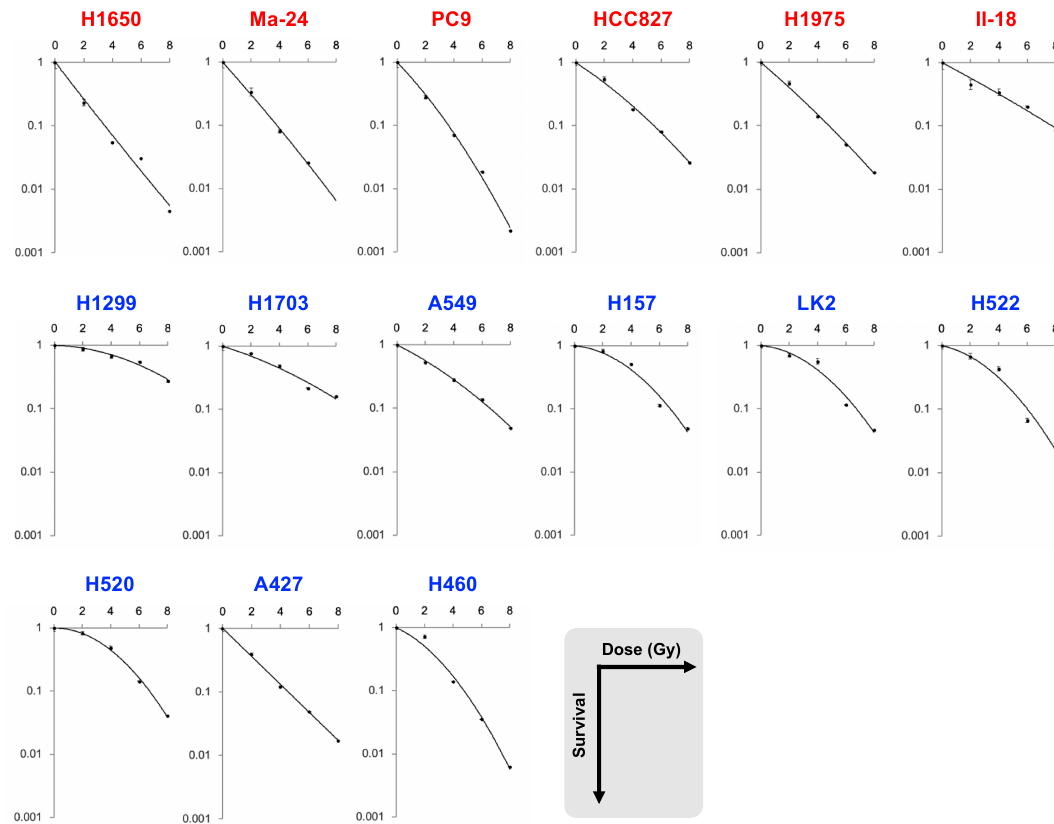
Figure 2. Dataset B: Survival curves for EGFR mutant (red) and wild-type (blue) non-small cell lung carcinoma cell lines treated with X-rays.